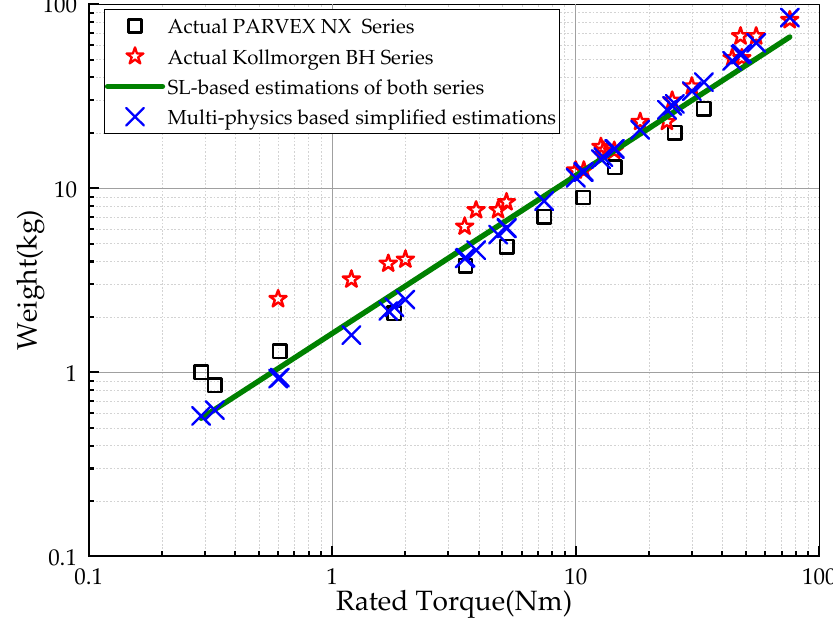
Figure 12. Weights of servo motor series of different models.